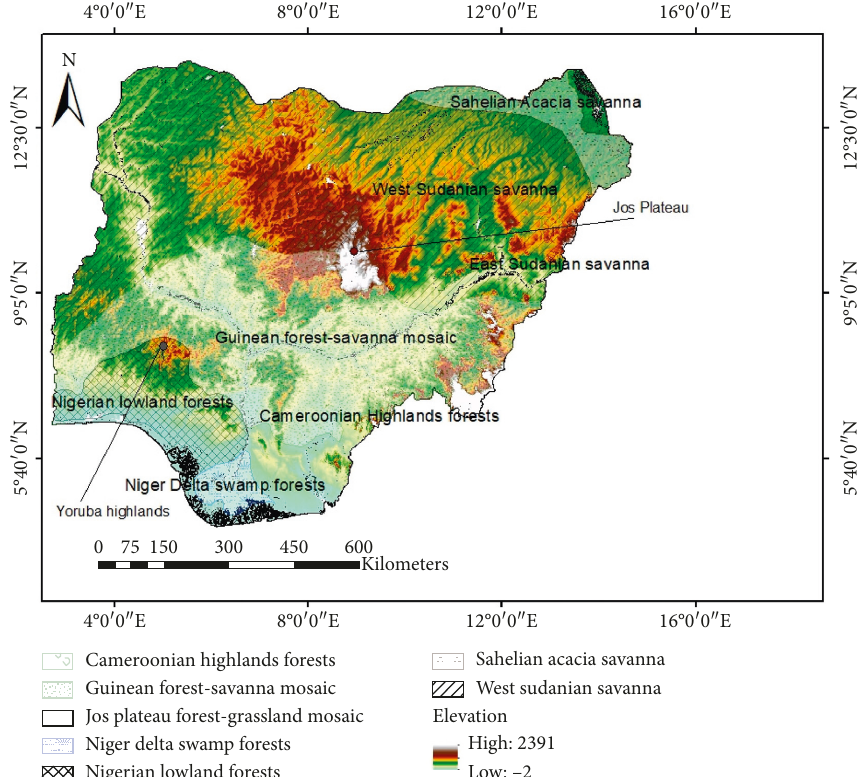
Figure 1: Location of the study